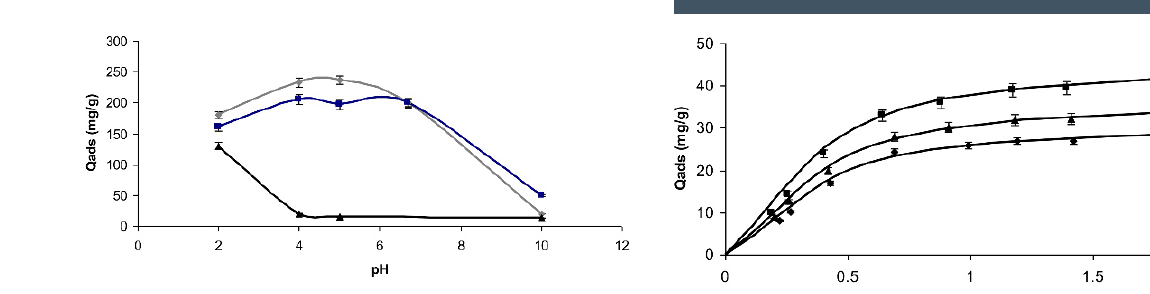
Figure 2. Influence of pH on phenol drifts adsorption ( (cid:7) ) ONP, ( (cid:4) ) OCP and ( (cid:78) ) SA over HBEA.